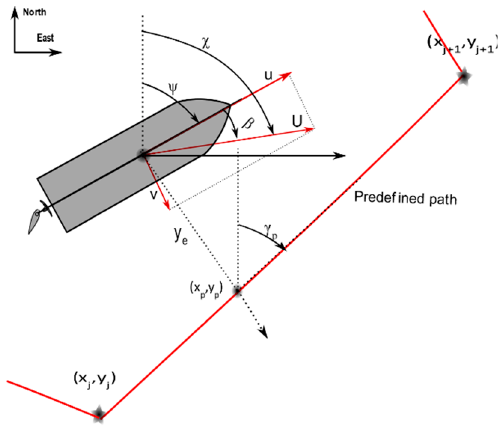
Figure 2. Geometry description of path-following control.